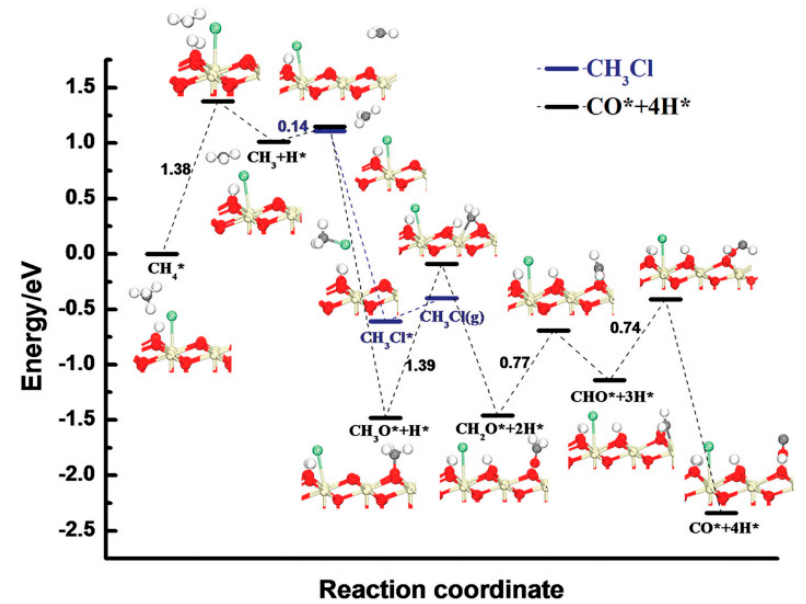
Figure 6. Calculated energy profiles and structures of the key states of CH 4 oxidation at CeO 2 (111) with co-adsorbed HCl. Reprinted with permission from [83]. with co-adsorbed HCl. Reprinted with permission from